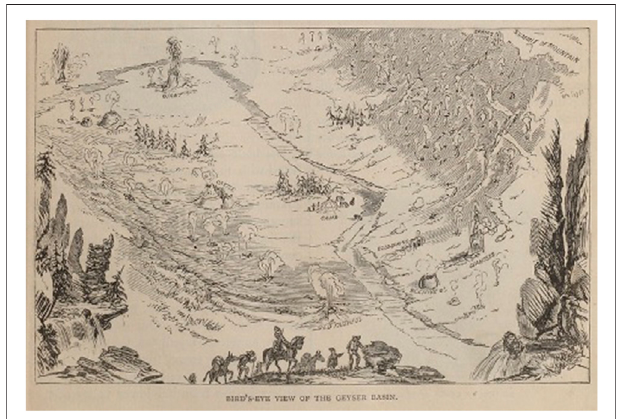
FIGURE 3 | Bird ’ s-eye view of the geyser basin, by Thomas Moran. Featured in Part 2 of Langford ’ s Wonders of the Yellowstone (1872).